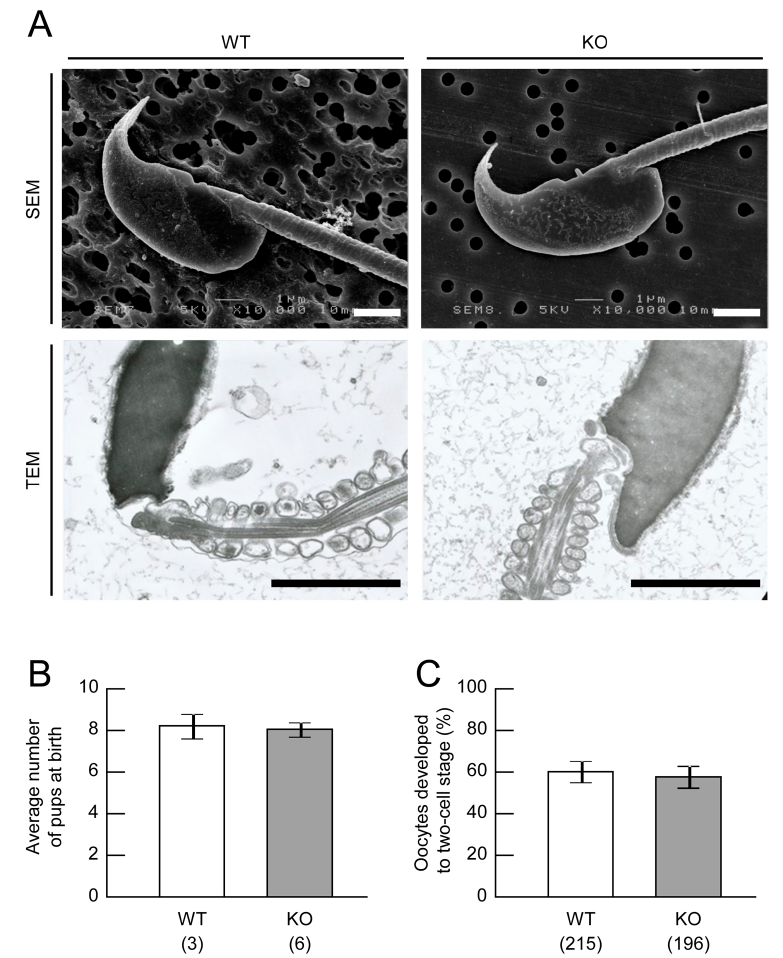
Figure 2. Sperm analyses. ( A ) Sperm morphology observed by scanning electron microscopy (SEM) and transmission electron microscopy (TEM). WT, wildtype; KO, knockout. Scale bars = 2 µ m; ( B ) Average number of pups born from WT mothers. The numbers in parentheses indicate the numbers of male mice examined. Values are the mean ± standard error of the mean; ( C ) The percentage of oocytes developed to two-cell stage 24 hours after in vitro fertilization. The numbers in parentheses indicate the numbers of WT oocytes examined. Values are the mean ± standard error of the mean.